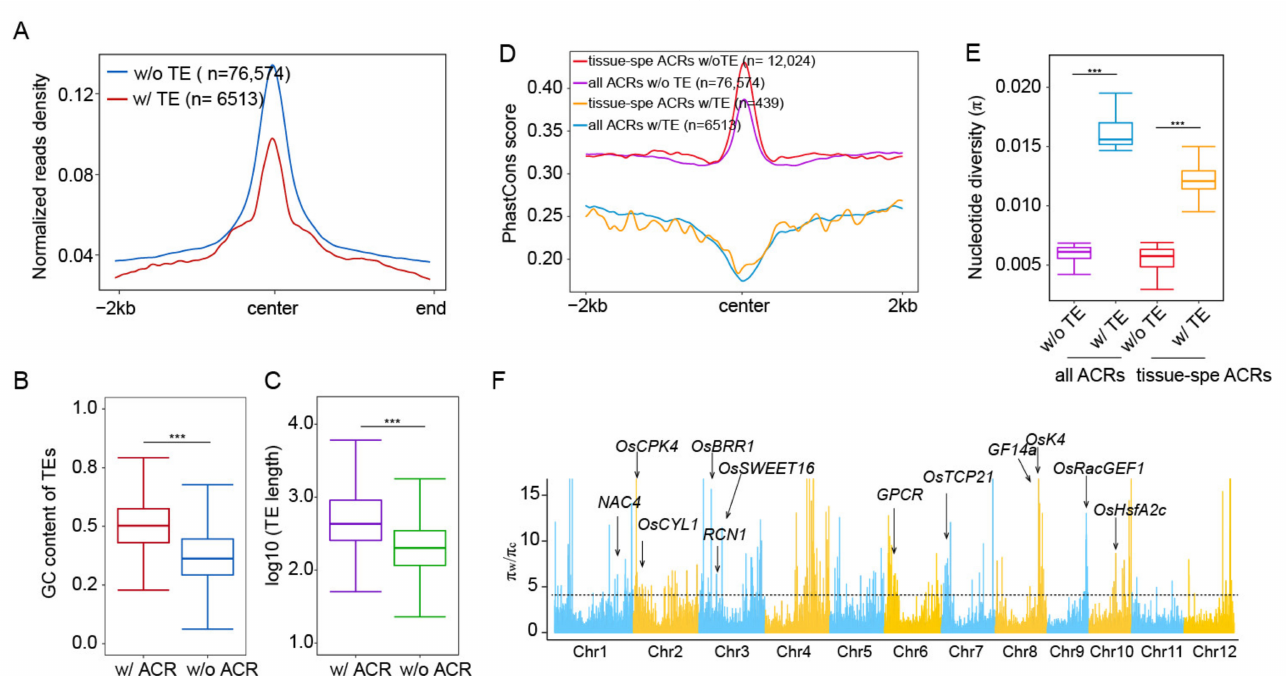
Figure 4. Genomic features and conservation of TE-derived ACRs. ( A ) Curve plot demonstrating normalized ATAC-seq read density across ± 2 kb of the center of ACRs with ( w /)/without ( w / o ) TEs in flag leaf (FL). ( B ) Boxplot showing the difference of GC content of TE (with/without ACRs). Significance test was determined using Wilcoxon rank sum test, *** p < 0.001. ( C ) Boxplot showing the difference of TE (with/without ACRs) length. Significance test was determined using Wilcoxon rank sum test, *** p < 0.001. ( D ) Averaged phastCons score across 4 kb regions centered by all ACRs and tissue-specific ACRs, with or without TEs. ( E ) Boxplot demonstrating mean π values around 2 kb region of ACRs with/without TEs. Significance test was determined using Wilcoxon rank sum test, *** p < 0.001. ( F ) Selection signals in the rice genome. The horizontal black dashed lines showing the genome-wide threshold for domestication sweeps ( π w / π c > 4.1). Functional genes overlapped with TE-derived ACRs under domestication selection were labeled in corresponding